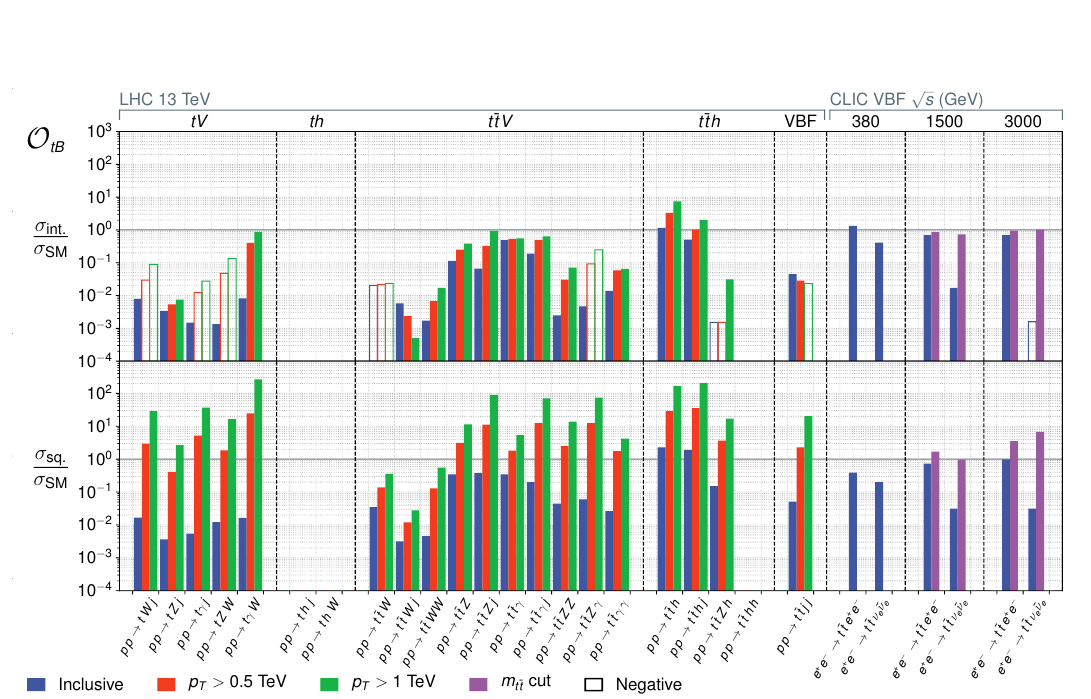
Figure 45. Same as (cid:12)gure 40 for